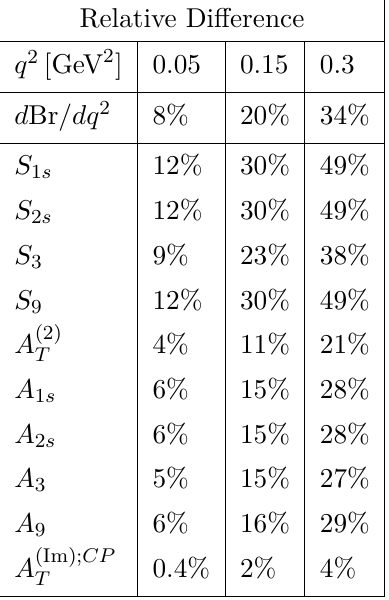
, 0 . 3 GeV 2 ] . For d Br /dq 2 , S 1 s , S 2 s , S 3 , e , A , A , A and A ( Im ); CP we consider 1 s 2 s 3 9 T